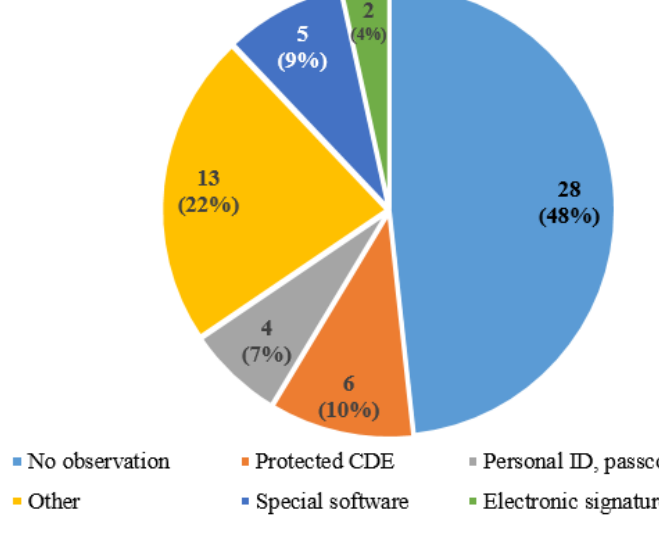
Figure 7. Observation of information security in a collaborative design.